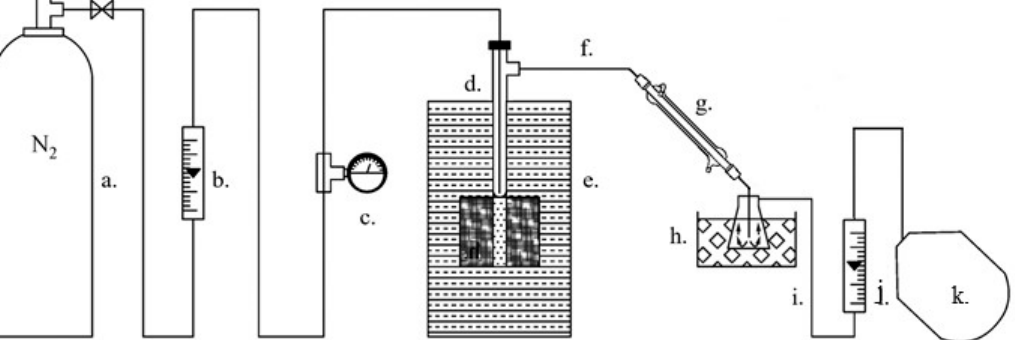
Figure 4. Pyrolysis experimental set-up: a . N 2 cylinder, b . upstream flowmeter, c . manometer, d .